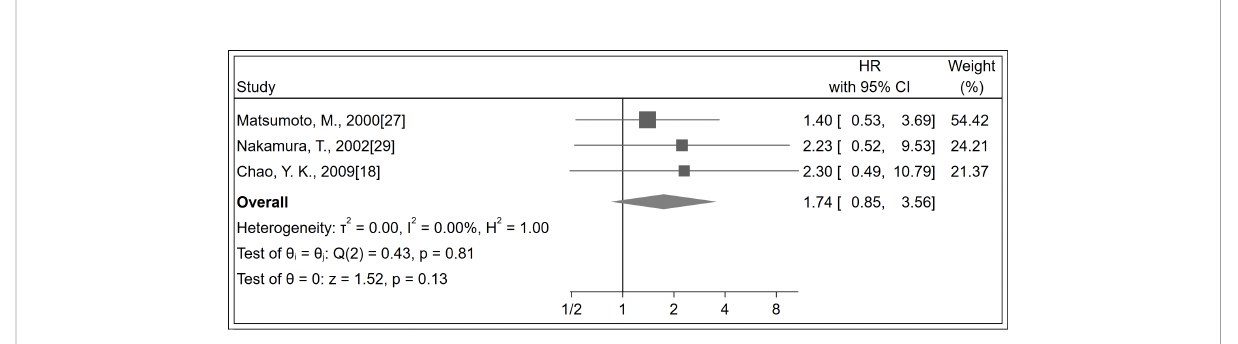
FIGURE 4 Forest plot of recurrence.